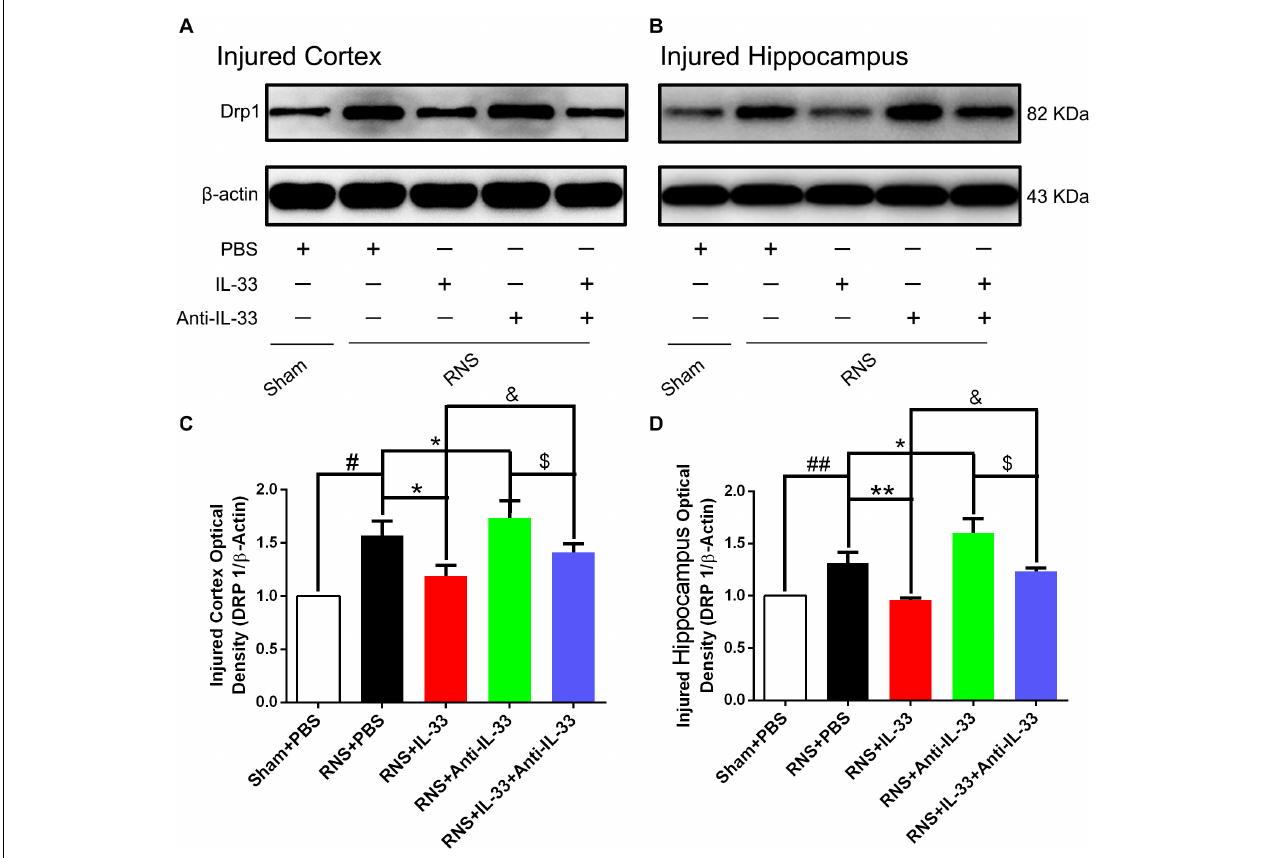
FIGURE 6 | IL-33 reversed RNS-induced the increase of Drp 1 after RNS. (A,B) Administration of IL-33 alone reversed RNS-induced up-regulation of Drp 1 expression level, while Anti-IL-33 alone treatment further down-regulated the expression level of Drp 1. However, the combined treatment of IL-33 and Anti-IL-33 reversed the effect of IL-33 alone or Anti-IL-33 on the expression level of Drp 1 in both cortex and hippocampus at 72 h post-RNS. (C,D) Optical densities of the protein bands were quantitatively analyzed, and normalized with loading control β -actin. The data were expressed as means ± SEM ( n = 4–6). ## P < 0.01 vs. Sham + PBS group, # P < 0.05 vs. Sham + PBS group. ** P < 0.01 vs. PBS group, * P < 0.05 vs. PBS group. & P < 0.05 vs. RNS + IL-33 group. $ P < 0.05 vs. RNS + Anti-IL-33 group. Experiments are representative of three independent